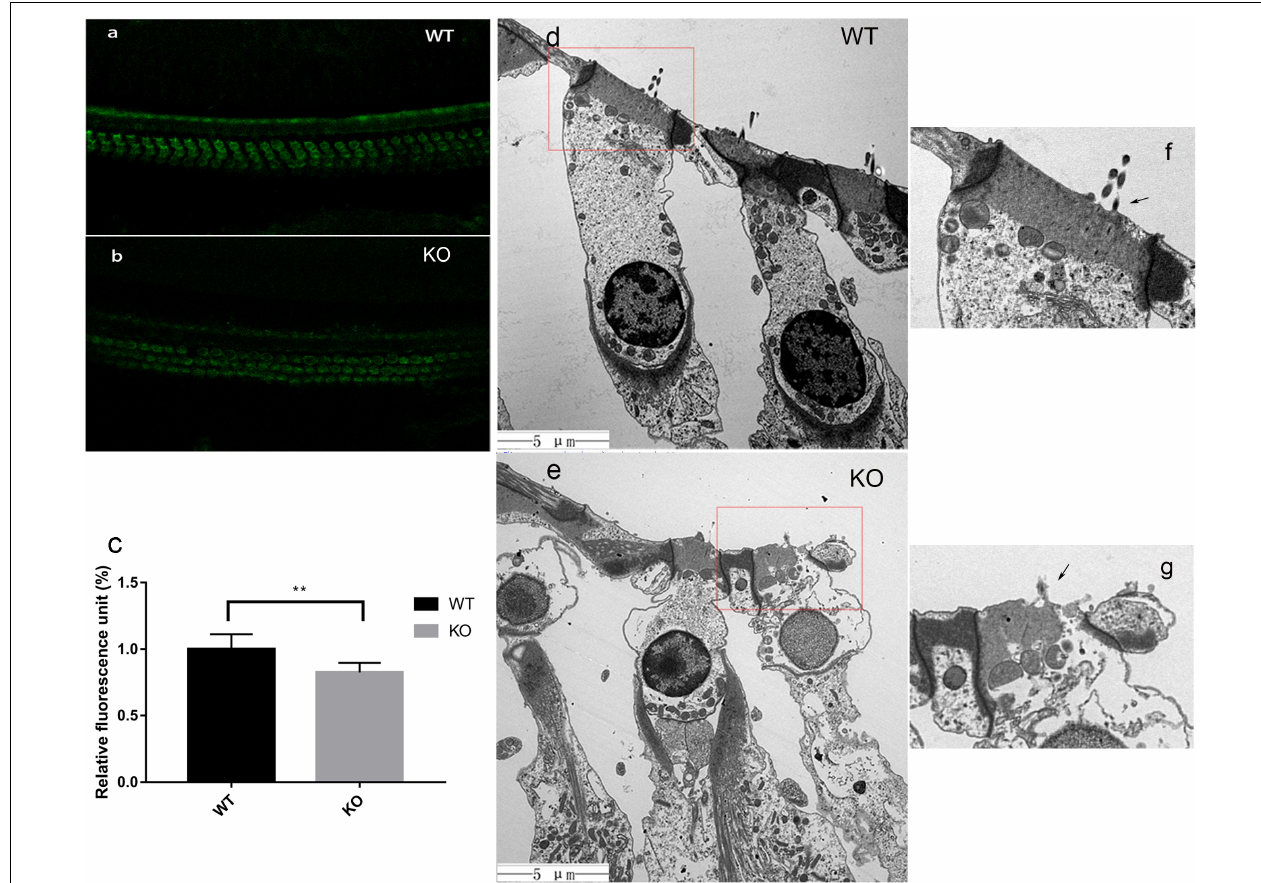
FIGURE 6 | In KO mice, the FM1-43 uptake decreased and cell edema began to appear at the end phase of stereocilia degeneration. (a,b) FM1-43 uptake in hair cells of WT and Smpx KO mouse at p60. This image indicated that the shortest row stereocilia degeneration did not greatly affect the uptake of FM1-43. (c) relative fluorescence unit of FM1-43 uptake. The uptake in KO mice at p60 was reduced by 17%. (d,e) Transmission electron microscope of hair cells in WT and Smpx KO mouse at p150. In panel (e) , the cellular contents were disturbed by water, and swelling appeared on the surface of cell membrane. Undoubtedly, these were characteristics of cell edema. This state of hair cells was more sensitive. (f,g) Magnified image of panels (d,e) . In panel (g) , the longest row was still remaining (arrowed), which indicated that cellular edema occurred during the stereociliary degenerating process but not after the process. ** means 0.01 > p value >